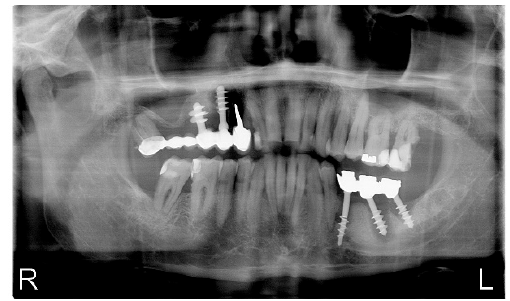
Figure 2. Preoperative panoramic x-ray.